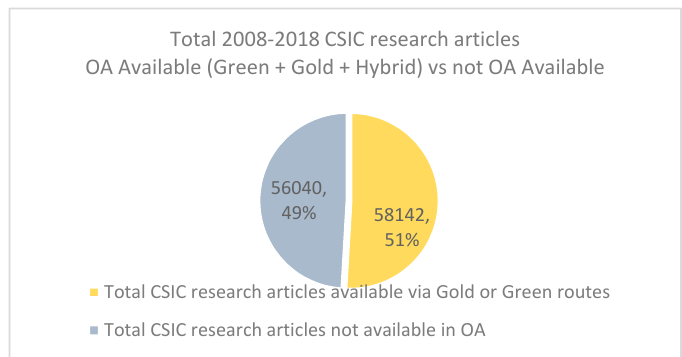
Figure 1. Percentage of Spanish National Research Council (CSIC) research articles available in Open Access (OA) as compared to total volume of CSIC research articles published in